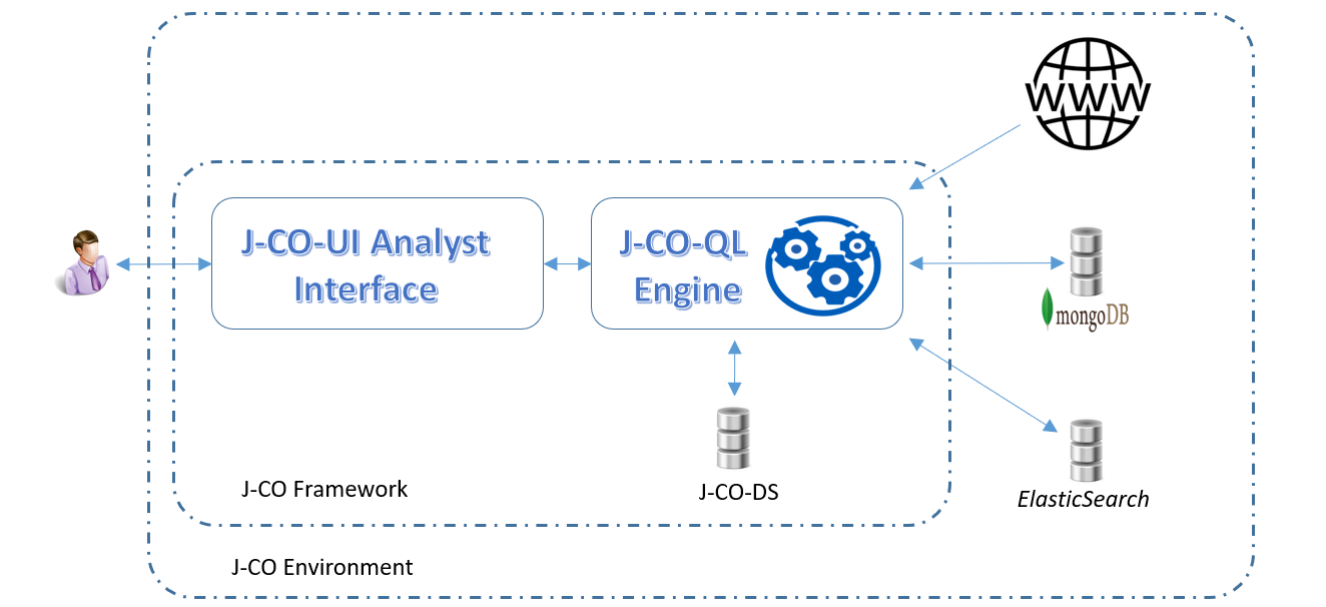
Figure 1. The J-CO Framework within the J-CO